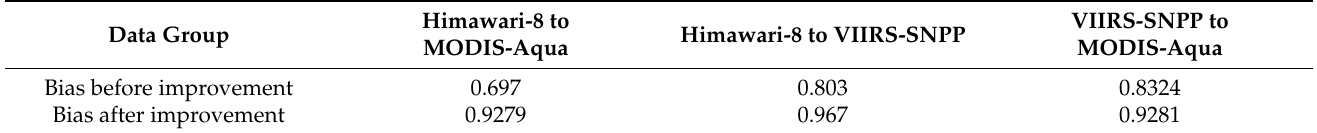
Table 9. Cross-consistency between sensors calculated by the bias before and after algorithm im- provement.